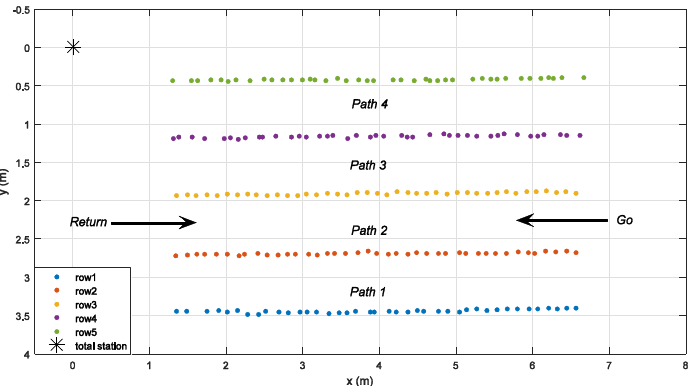
Figure 2. Representation of the total station location (*), the directions travelled by the robot during data acquisition, and the plant positions of the five maize rows (∙).